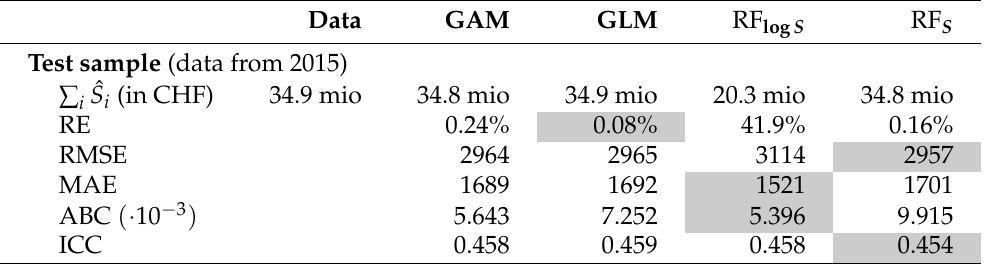
Table 4. Comparison of the total predicted claim severity ∑ i ˆ S i , GOF and GOL across the GAM, GLM, and RF models in the test